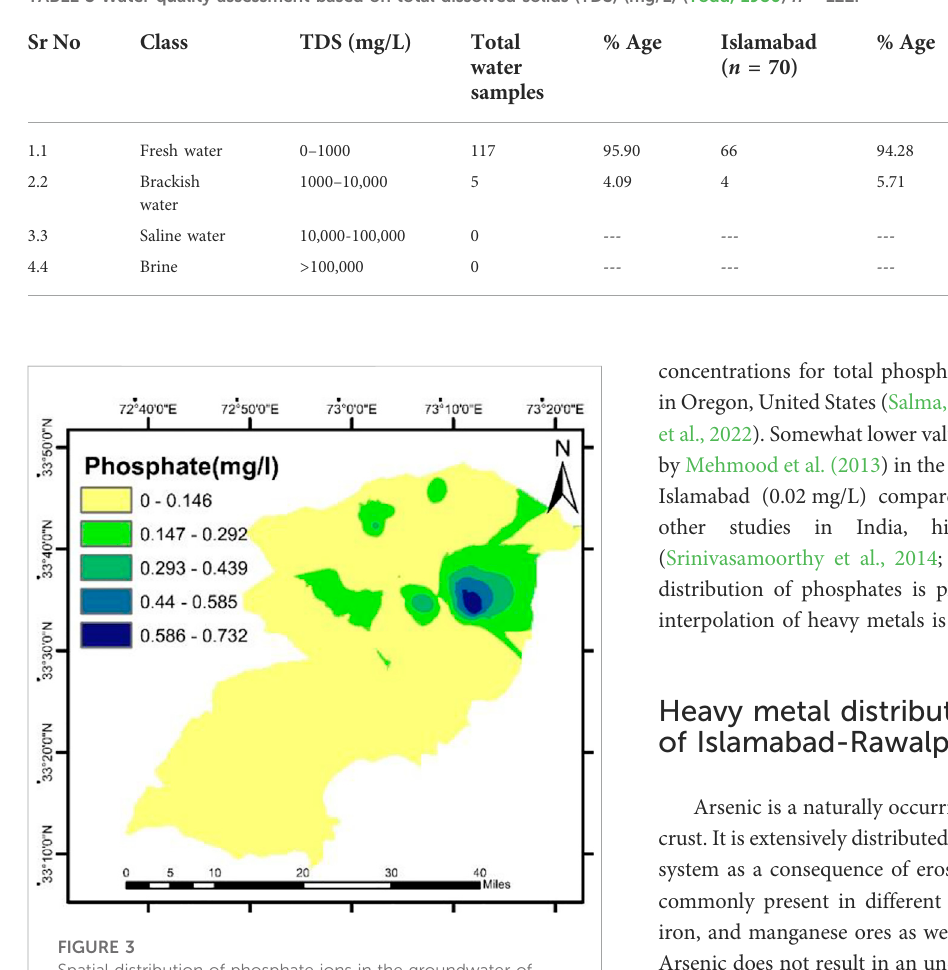
FIGURE 3 Spatial distribution of phosphate ions in the groundwater of Rawalpindi and